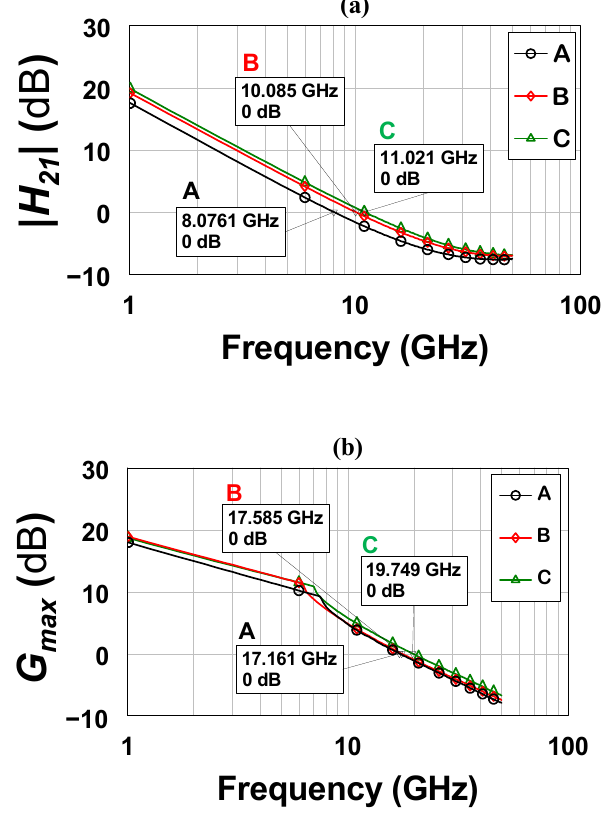
Figure 7. The small-signal gain characteristics current gain ( a ) and maximum available gain ( b ) ob- tained at V ds = 4.5 V and V gs = − 2.5 V.